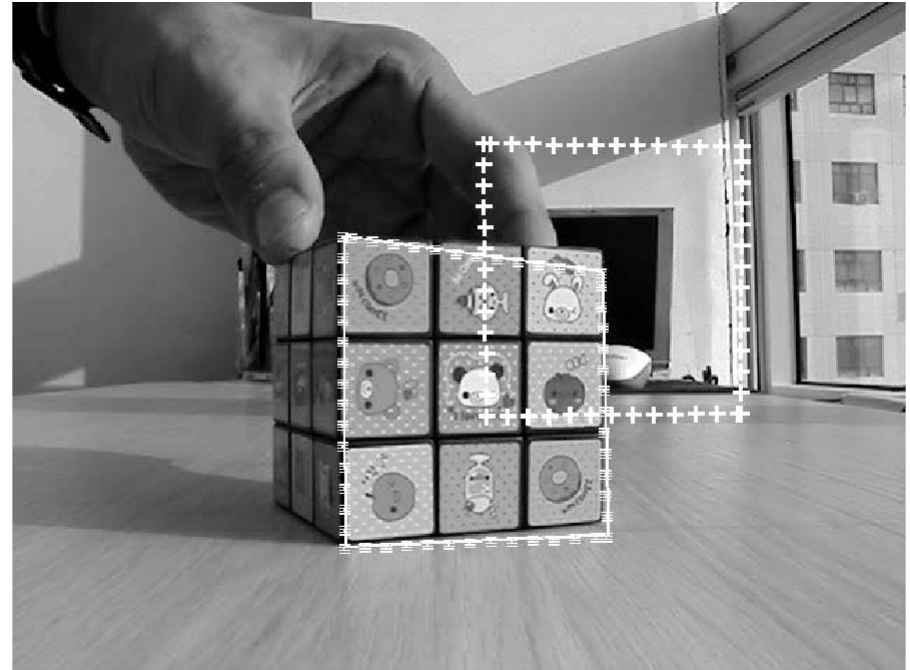
Figure 4. Conceptual comparison of the proposed method with contemporary methods. The leftmost picture is the given template. Areas to be used as indicators of comparison are marked with white highlight lines. In the target images given on the right, the area marked by the solid line (the proposed method) was deformed to match the target image, like the area marked by the triple line (brute-force method). On the other hand, the area indicated by the cross line (correlation method) was not deformed. Table 1. Average position errors (in pixels) of the entire Figure 4 experiment.